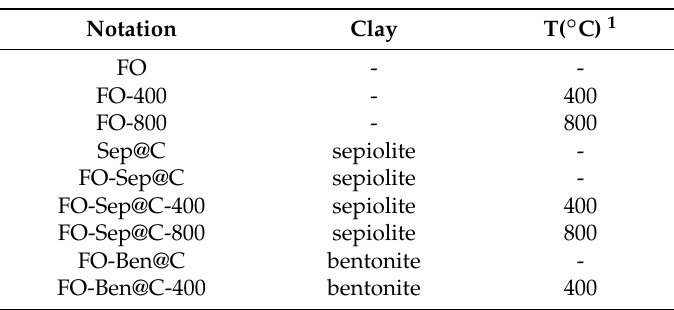
Table 1. Notation of the